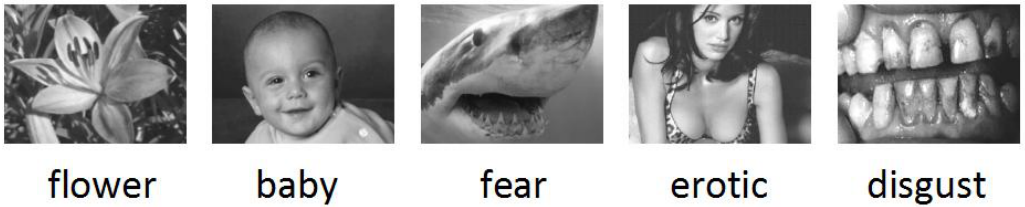
Figure 1. Example pictures for each